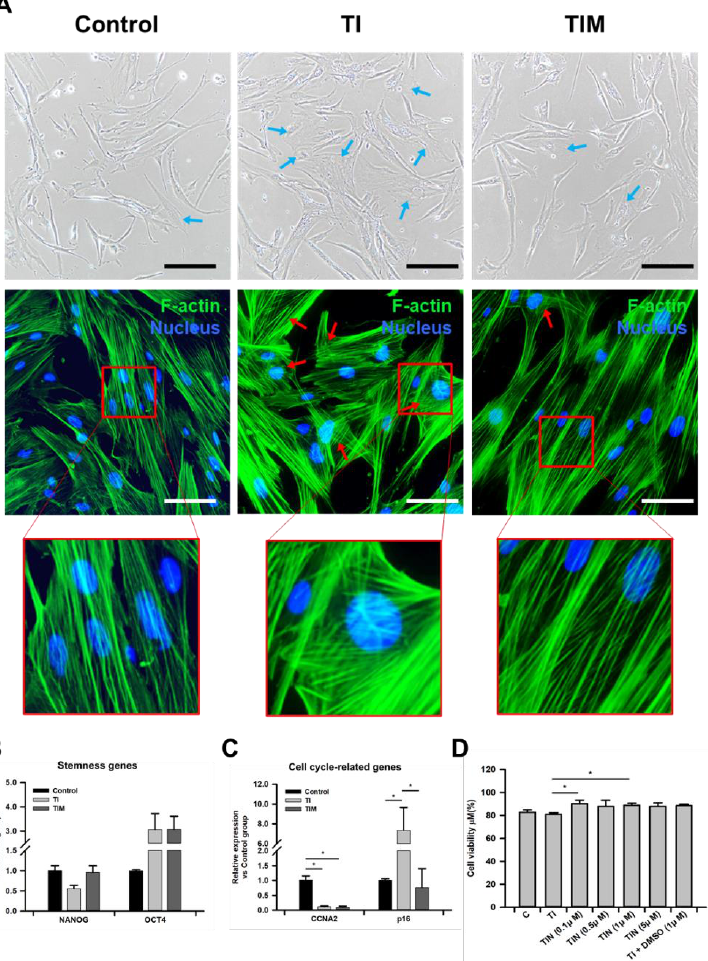
Figure 1. Characterization of hPD-MSCs. ( A ) Representative bright-field images (up) and fluores- cence microscopy images of hPD-MSCs (down). Phalloidin for F-actin and Hoechst33342 for the nuclei were used to visualize the morphology of the hPD-MSCs. Blue arrows indicate abnormal MSCs that lost their thin and spindle-like shapes. Red arrows indicate disrupted, crisscrossed, and unorganized microfilaments vertical to the cell axis. Black scale bar, 200 µ m, White scale bar, 100 µ m. ( B , C ) Expression of cell cycle progression (CCNA2), cell cycle inhibitor (P16), and stemness (NANOG and OCT4) genes were determined using quantitative real-time PCR. ( D ) Cell viability was calculated by dividing the cells unstained with Trypan blue by the total number of cells. C: control, TI: TNF- α + IFN- γ , TIM: TNF- α + IFN- γ + MIT-001. Data are presented as the mean ± SEM ( n = 3 for real-time qPCR data). Statistical significance was determined by a one-way ANOVA. * p <